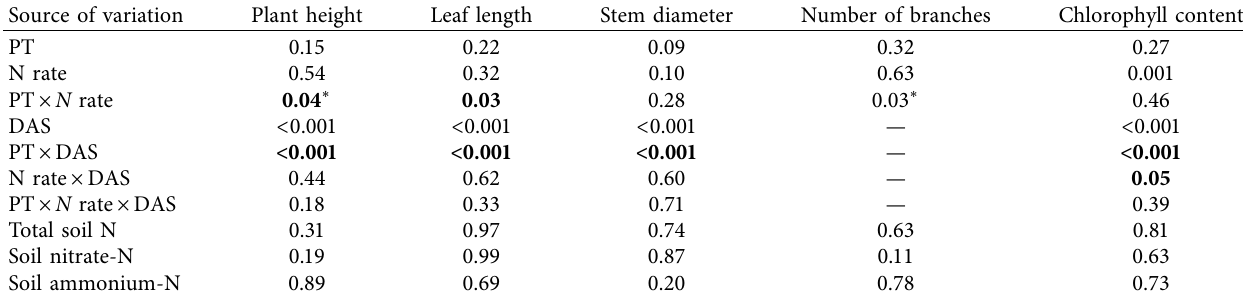
Table 3: Analysis of variance p values for the main and interaction effects of planting time (PT), nitrogen (N) rate, days after sowing (DAS), and total soil N, nitrate-N, and ammonium-N covariates on plant height, leaf length, stem diameter, and chlorophyll content.